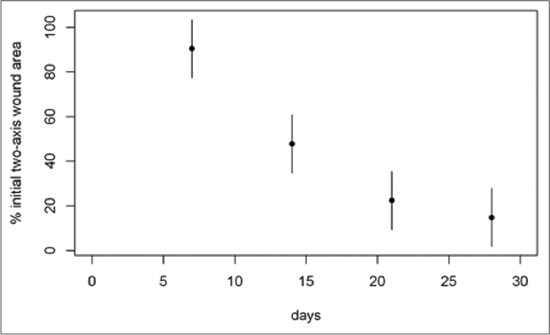
Mean percentage of “two-axis” wound area respect to T0 during the 1st month of treatment. The mean percentage of wound area at day 7 was 90.41% (95% confidence interval [CI]: 77.38-103.4), at day 14 was 47.74% (95% CI: 34.72-60.8), at day 21 was 22.38% (95% CI: 9.36-35.4) and at day 28 was 14.81% (95% CI: 1.78-27.8) of the original size.